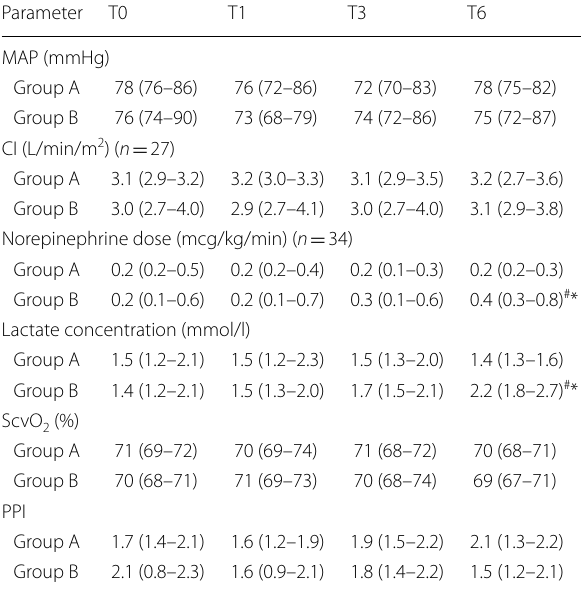
Table 2 Hemodynamic parameters during the study period in patients with (group B) and without (group A) altered